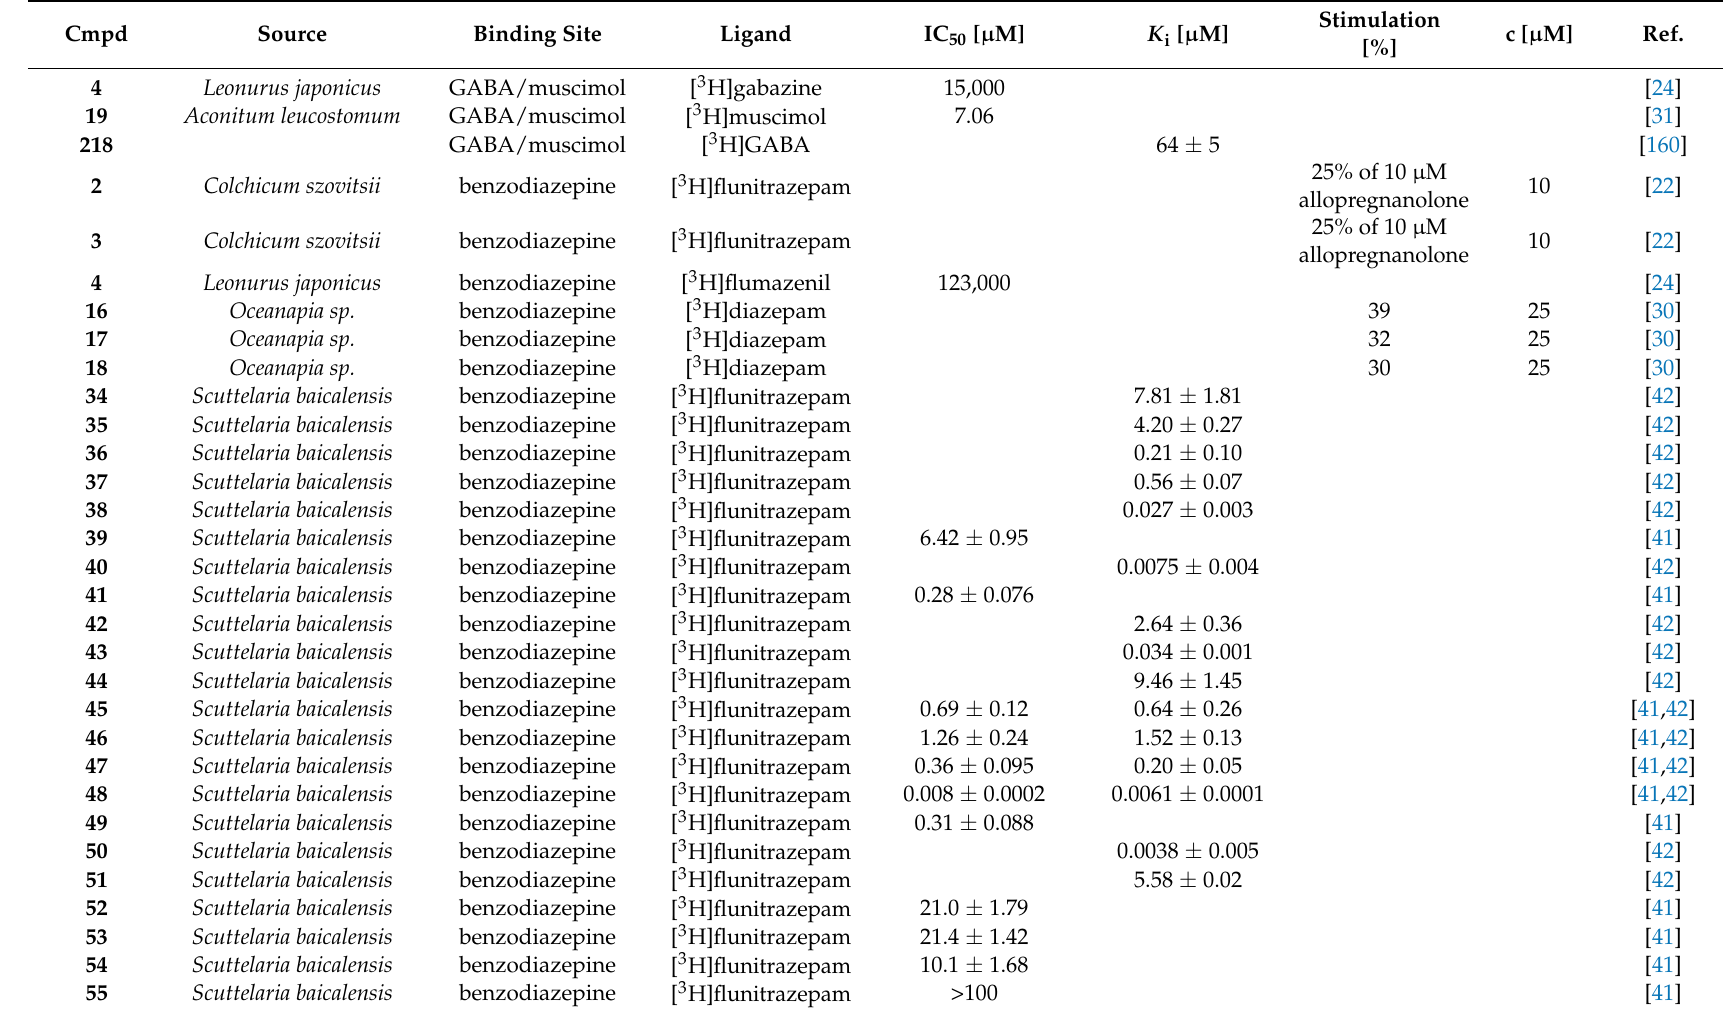
Table 3. Data from radioligand binding